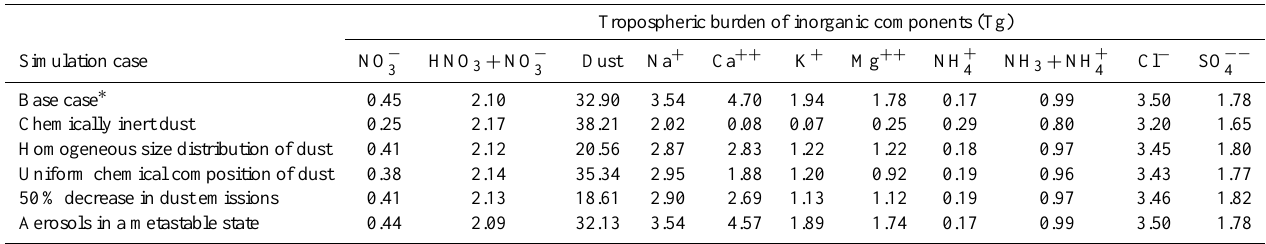
Table 5. Calculated average tropospheric burden of inorganic components in the base case and the sensitivity simulations. Tropospheric burden of inorganic components (Tg)